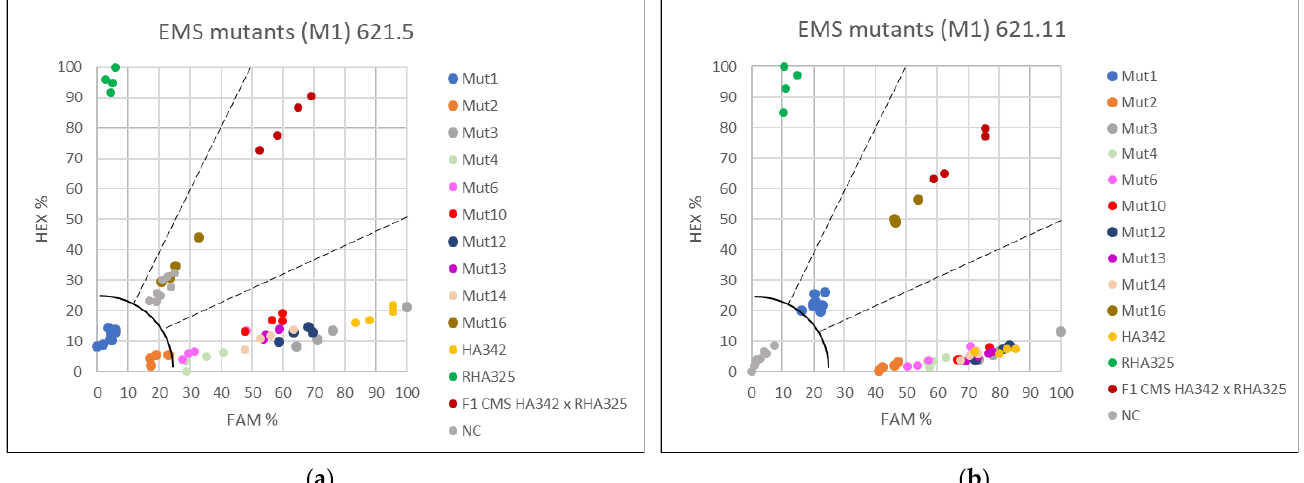
Figure 6. Investigation of the restorer locus Rf1 in EMS-treated plants (M1 generation) by application of two KASP markers. ( a ) Screening with KASP 621.5, ( b ) Screening with KASP 621.11. Seven male-sterile EMS mutants grouped together with the maintainer line HA342 ( rf1rf1 ) with all four KASP markers indicating that they do not contain a dominant restorer allele Rf1 , neither normal nor mutated by EMS. Mutant Mut10 showed a different behavior for the two PPR621-derived KASP markers than for the other two markers. For PPR621, both KASP markers (621.5 and 621.11) grouped Mut10 with the maintainer HA342, explaining the observed partial male sterility. For the KASP markers 841.38 and 861.19, Mut 10 grouped with the F1 hybrid cmsHA342 x RHA325 detecting a recombination event at the restorer locus Rf1 between these two SNPs and the two KASP markers for PPR621. As Mut10 was partially male sterile, this recombination indicates that HanXRQr2_Chr13g0608631 (PPR621) is more important for fertility restoration of PET1 than the other two candidate genes. Single plant KASP assays allowed classifying each plant into a group, either maintainer ( rf1rf1 ), restorer ( Rf1Rf1 ), or F1 hybrid ( Rf1rf1 ).